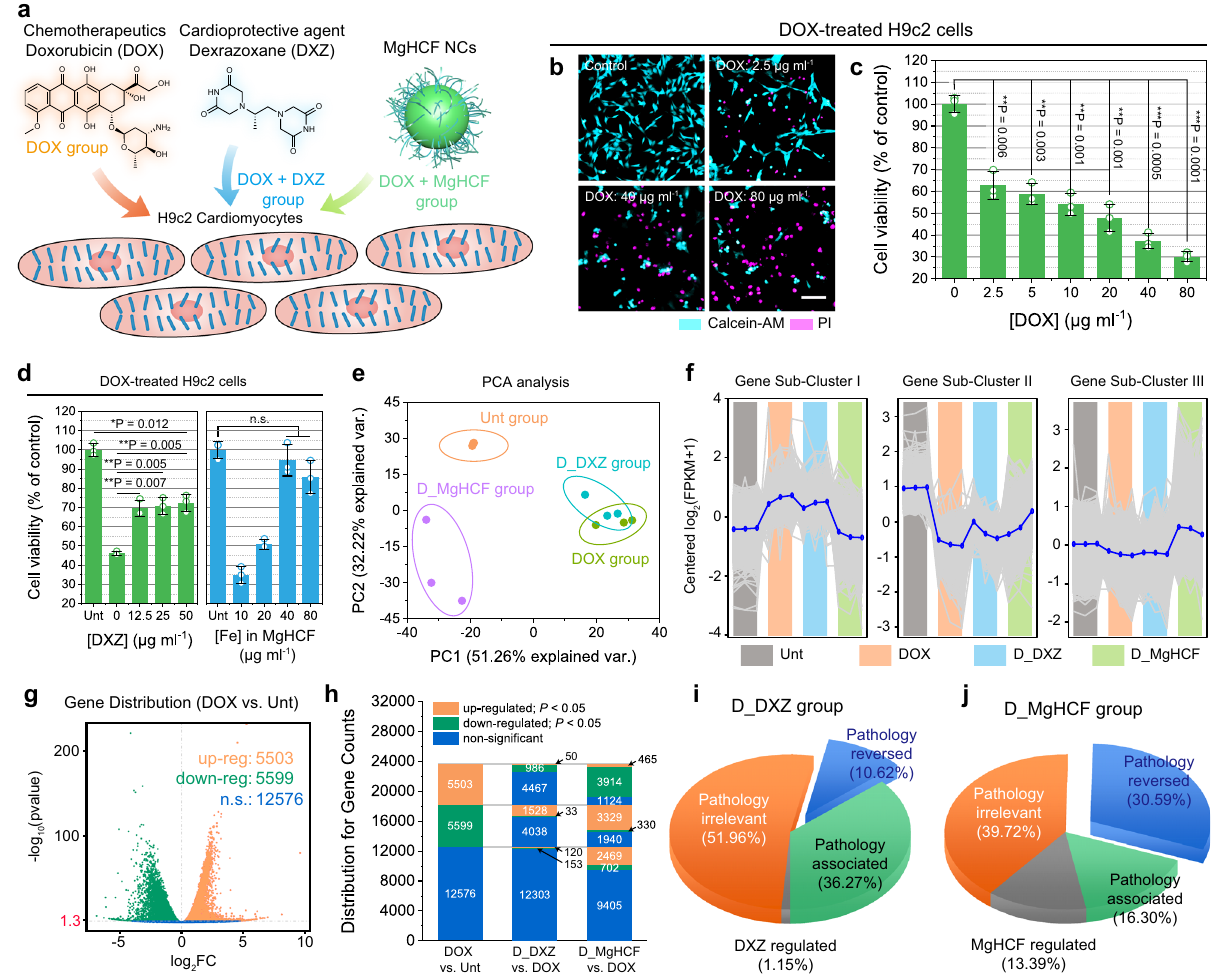
Fig. 4 | In vitro cellular evaluations and high throughput mRNA sequencing. a Schematicillustrationoftheinvitrocellularexperiments. b Confocalmicroscopic imagesofCalcein-AM/PI-stainedcellstreatedwithvaryingdosesofDOX.Scalebar: 50 μ m. c Viability of H9c2 cells treated with varying doses of DOX ( n =3 of biolo- gical replicates). Data are presented as mean±s.d. Statistical signi fi cance is asses- sedbyStudent t ’ sone-tailedtest.** P <0.01,*** P <0.001. d ViabilityoftheH9c2cells treated with DOX supplemented with different concentrations of DXZ or MgHCF ( n =3 of biological replicates). Data are presented as mean±s.d. Statistical sig- ni fi canceisassessed byStudent t ’ sone-tailedtest.* P <0.05,** P <0.01.n.s.fornon- signi fi cant. e PCA analysis for the cell samples in diff e rent groups. Data are